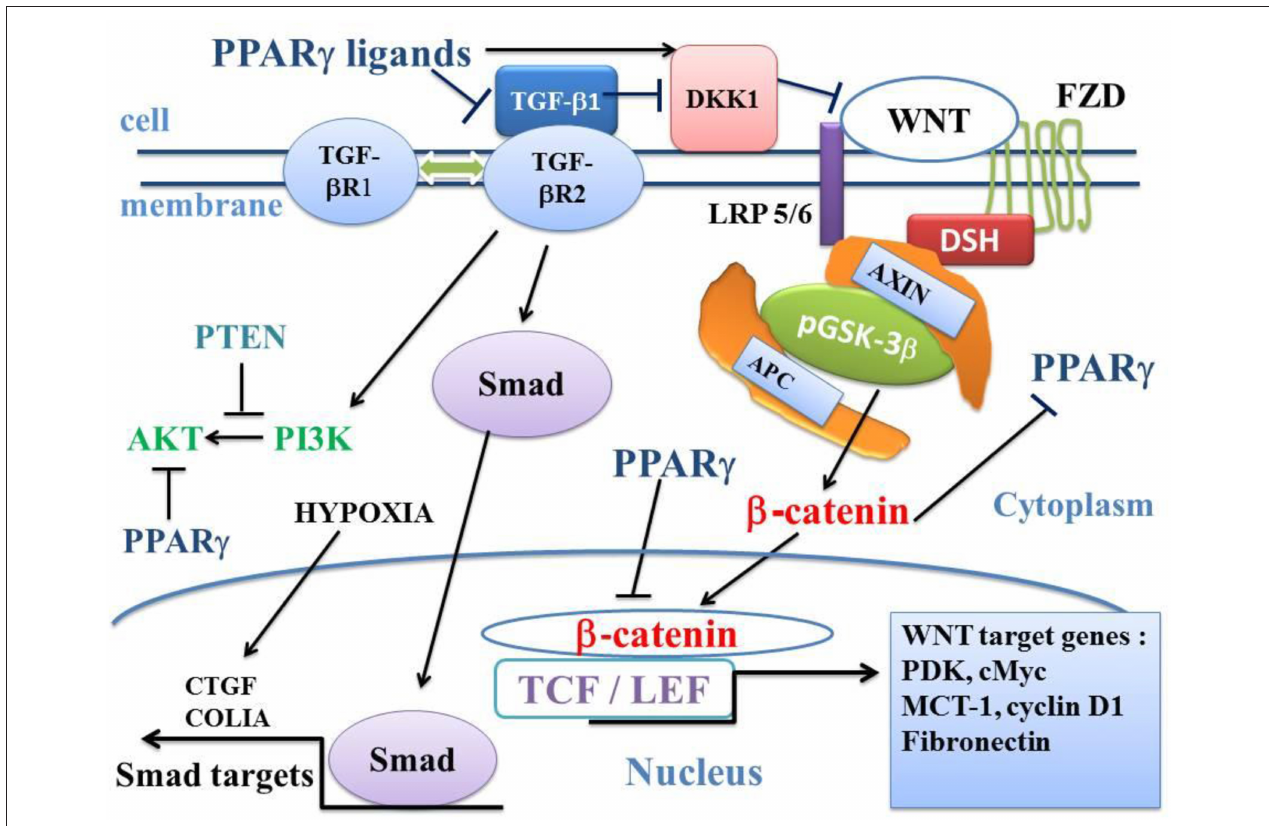
FIGURE 3 | Influence of TGF- β 1 on the balance between the canonical WNT/ β -catenin signaling and PPAR γ . In the presence of the WNT ligands, the WNT receptor binds both LRP5/6 and FZD receptors to initiate LRP phosphorylation and DSH-mediated Frizzled internalization. This leads to the dissociation of the GSK-3 β /AXIN/APC destruction complex. Phosphorylation of β -catenin is inhibited and β -catenin accumulates in the cytosol and then translocates to the nucleus to bind TCF-LEF transcription factors. This leads to the WNT-response gene transcription (PDK, MCT-1, cMyc, and Cyclin D1). PPAR γ inhibits the β -catenin/TCF-LEF-induced activation of WNT target genes. TGF- β also enhances WNT signaling through the inhibition of DKK1. DKK1 is activated by PPAR γ . TGF- β 1 binds type 2 TGF- β R2 receptor (TGF- β R2), which recruits type 1 TGF- β R1 receptor (TGF- β R1). This results in the formation of a heterotetramer that phosphorylates Smad. The Smad complex then translocates to the nucleus and regulates the transcription of target genes (CTGF, COL1A). A non-Smad pathway also occurs through PI3K-AKT. PTEN inhibits PI3K-AKT and PPAR γ inhibits AKT. APC, adenomatous polyposis coli; CTGF, Connective tissue growth factor; DKK1, Dickkopf-1; DSH, Disheveled; FZD, Frizzled; GSK-3 β , glycogen synthase kinase-3 β ; LRP5/6, low-density lipoprotein receptor-related protein 5/6; MCT-1, monocarboxylate lactate transporter-1; PPAR γ , peroxisome proliferator-activated receptor gamma; PI3K, phosphatidylinositol 3-kinase and AKT, AKT/Protein Kinase B; PTEN, Phosphatase and tensin homolog; PDK, pyruvate; dehydrogenase kinase; TCF/LEF, T-cell factor/lymphoid enhancer factor; TGF, Transforming Growth